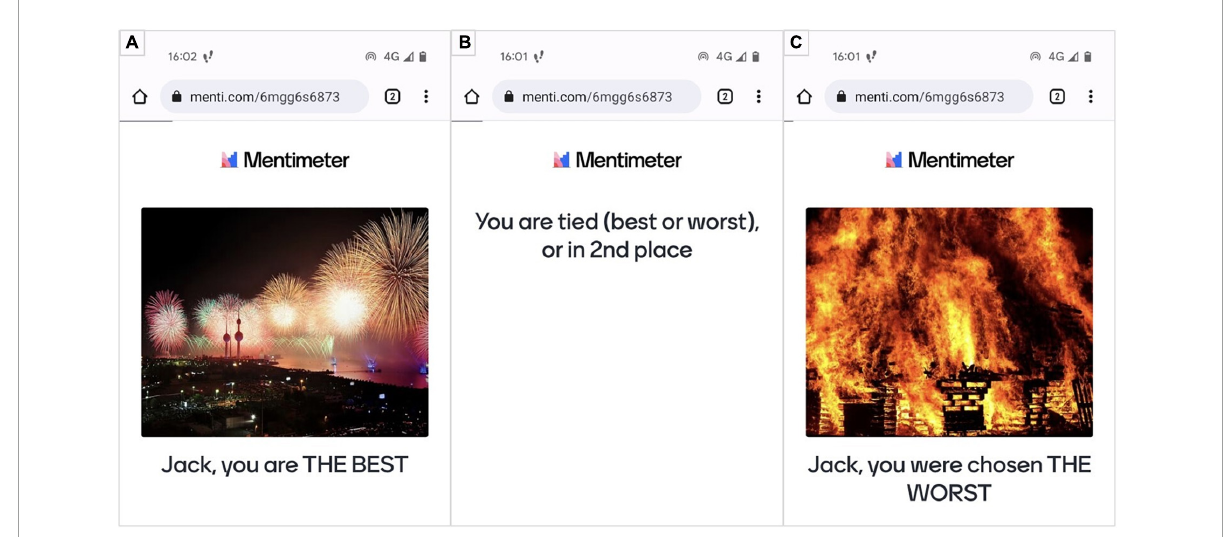
FIGURE4 Emotion induction with positive feedback and positively valenced image from the OASIS database (A) , neutral state (B) , and negative emotion induction with negatively valenced image from the OASIS database (C)